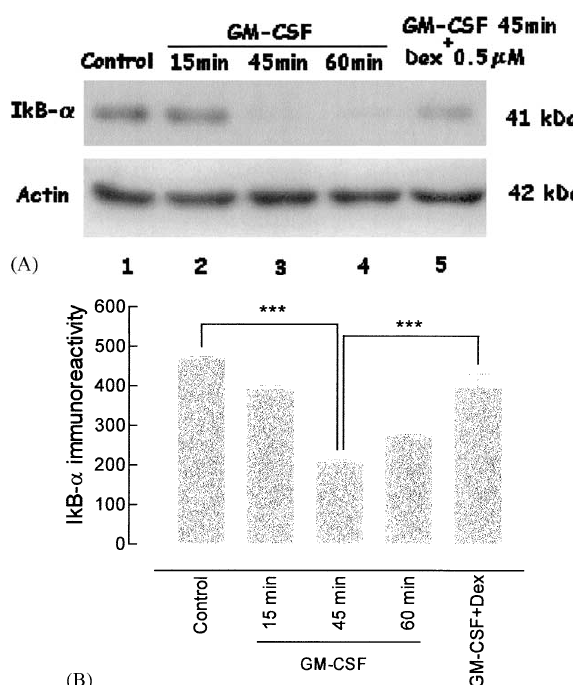
FIG. 4. Effect of dexamethasone (Dex) on GM-CSF-stimulated I k B- a decrease in FSDC. FSDC (2 (cid:3) / 10 6 cells) were incubated in culture medium alone (control, lane 1) or in the presence of 100 ng/ml of GM-CSF for 15, 45 and 60 min (lanes 2 (cid:1) / 4). Lane 5 corresponds to cells pre-incubated with 0.5 m M dexamethasone for 30 min before the stimulation with 100 ng/ml of GM-CSF for 45 min. Cytosolic cell extracts were electrophoresed through sodium dodecyl sulfate-polyacry- lamide gel electrophoresis, transferred to polyvinyl difluor- ide membranes and subjected to immunoblot analysis using an anti-I k B- a antibody as described in Materials and meth- ods. The membrane was stripped and reprobed with an anti- actin antibody to confirm equal protein loading. (A) Western blot analysis of I k B- a and actin protein levels. The blot shown is representative of three blots yielding similar results. (B) The bands were quantified with an image analyzer and the results are shown as means 9 / standard error of the mean from three independent experiments. ***p B / 0.001, as determined by one-way analysis of variance with Bonferroni’s multiple comparison